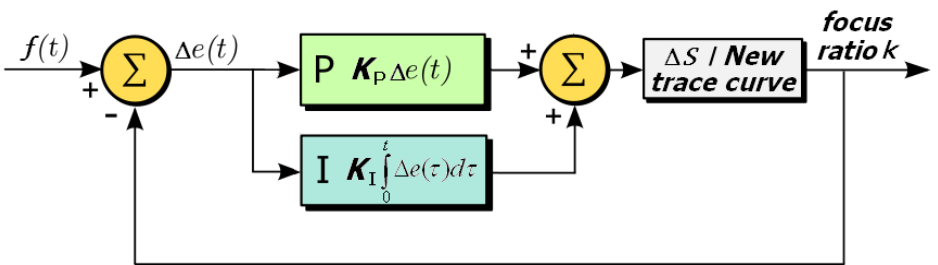
Figure 11. Control structure of